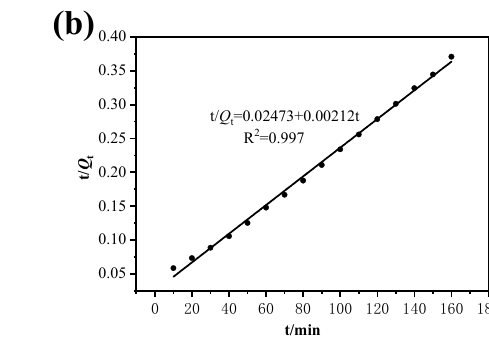
Table 4. Copper ion adsorption kinetic parameters of MGO@ZIF-8.